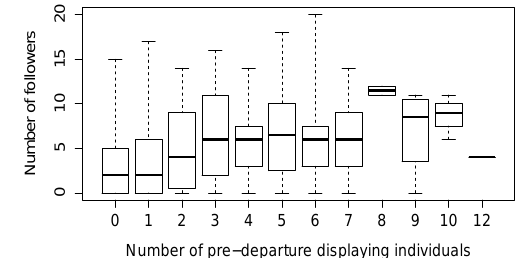
Figure 2. Effect of pre-departure behavior on the number of followers. The number of followers significantly increased with the number of pre-departure displaying individuals prior to de- parture (GLMM, estimate = 0.14, SE = 0.02, Z = 8.56, N = 283,